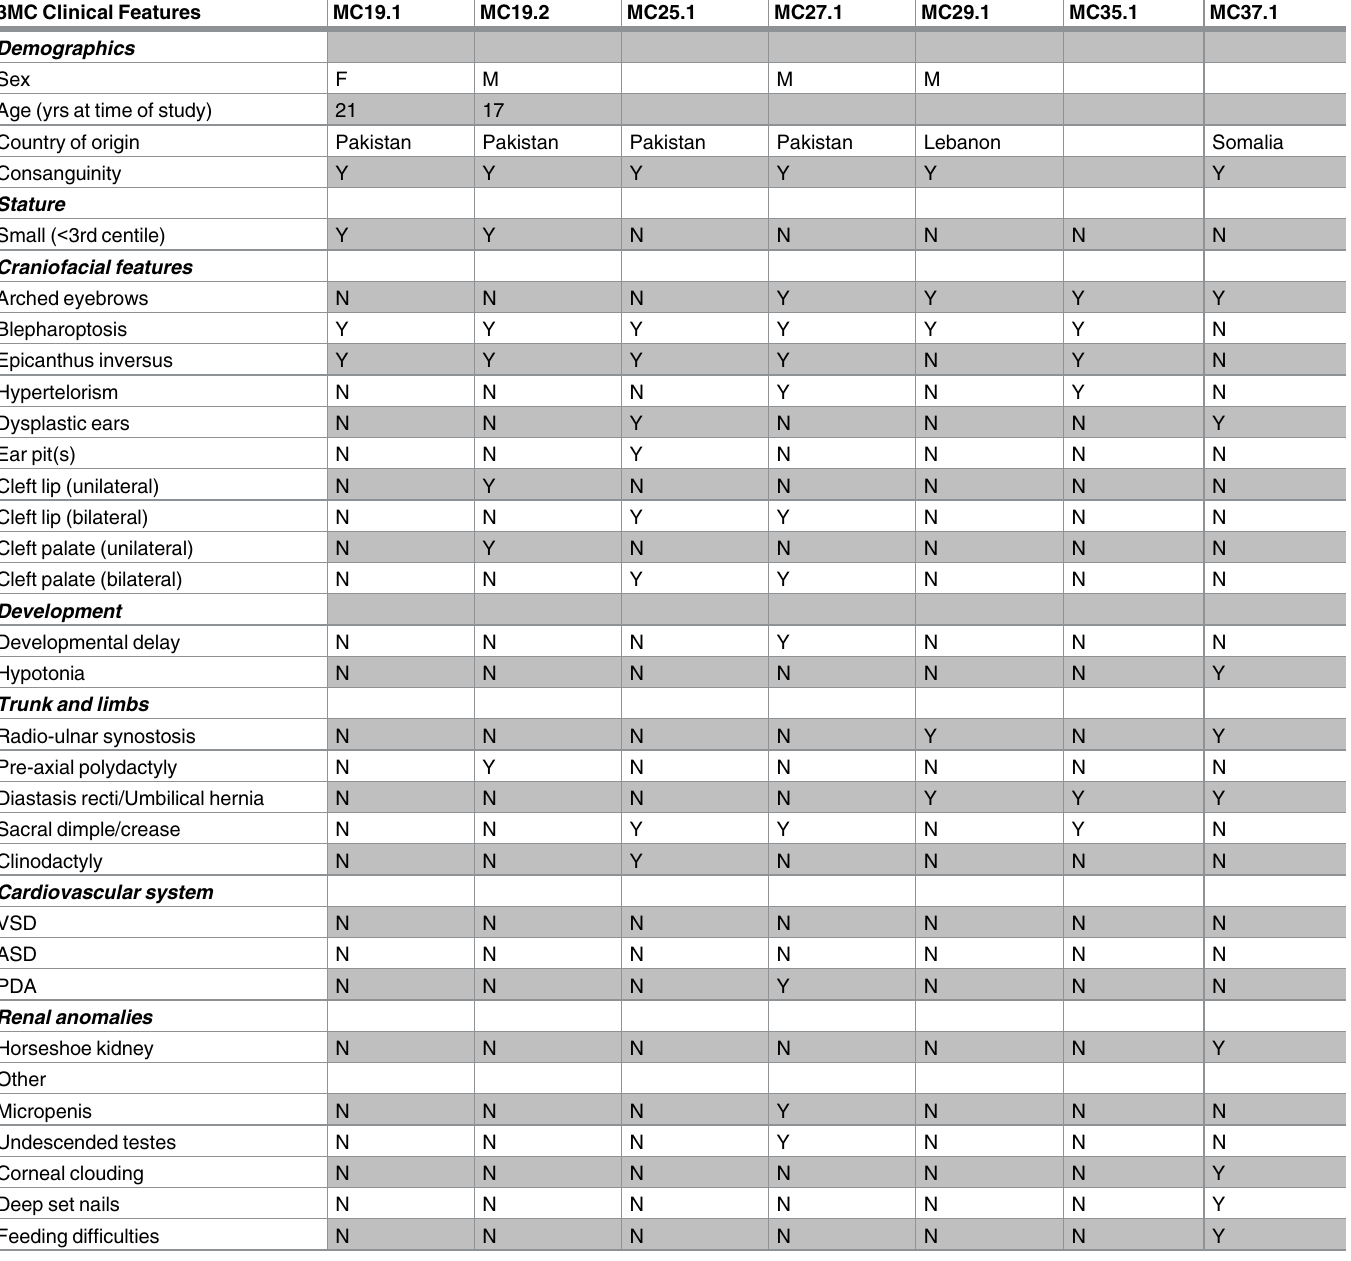
Table 3. Detailed clinical features for all 3MC described